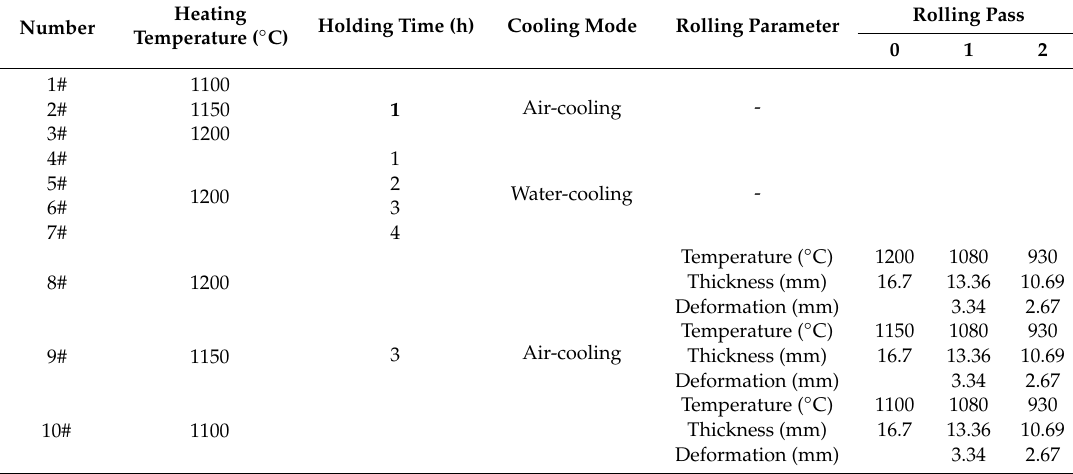
Table 3. Heating progression